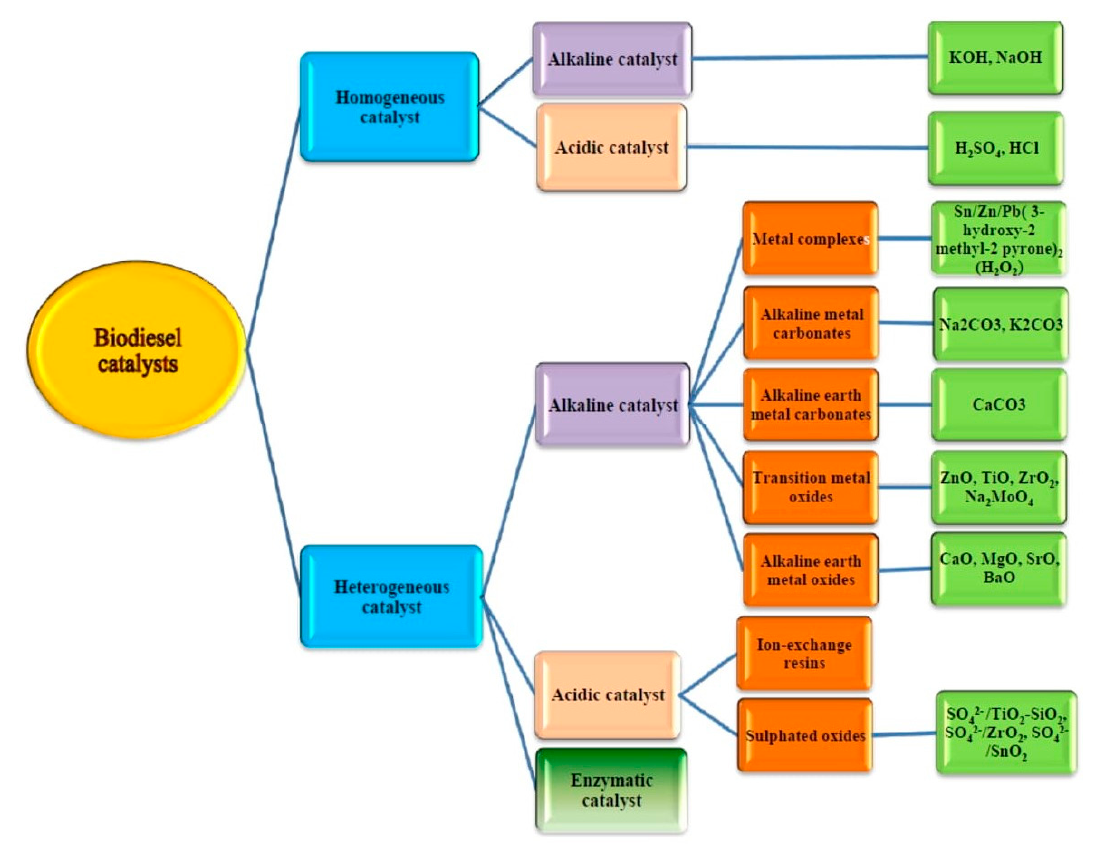
Figure 5. Catalysts classification in biodiesel production [78].